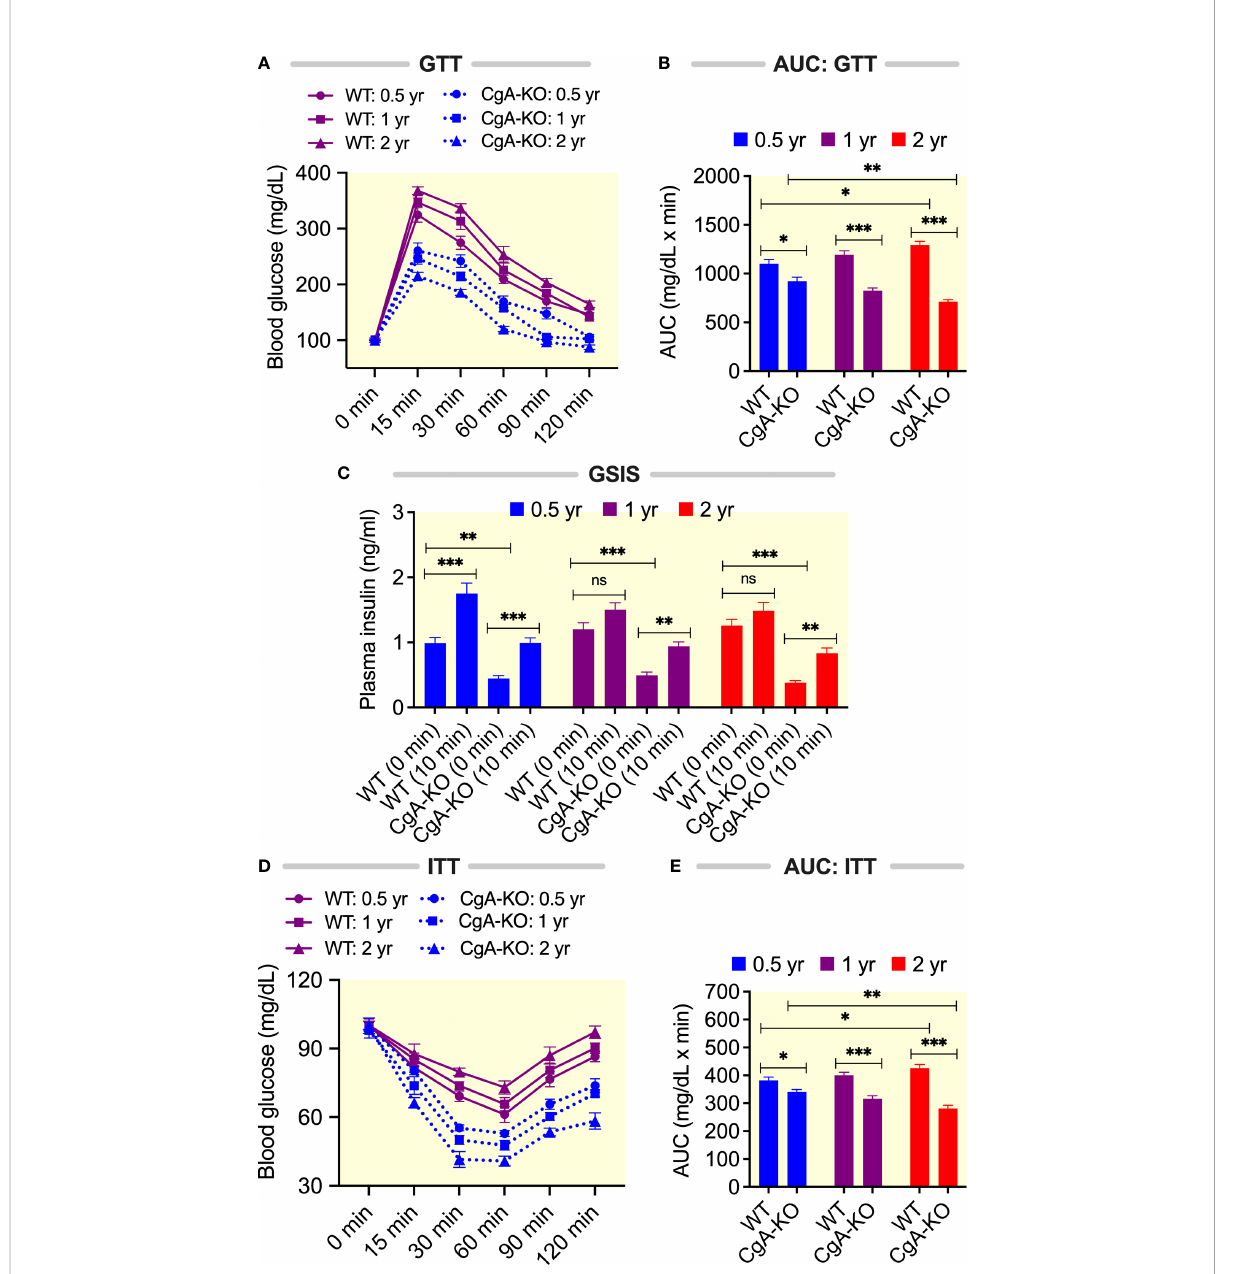
FIGURE 5 Aging CgA-KO mice maintain and improve glucose tolerance and insulin sensitivity. (A) Glucose tolerance test (GTT, n=7) with 8h fasting 0.5, 1 and 2 yr old WT and CgA-KO mice and (B) the corresponding areas under the curve (AUC). 2-way ANOVA. Interaction: p<0.001; Time: p<0.001; Genotype and age: p<0.001. (C) Glucose-stimulated insulin secretion (GSIS) with 8h fasting mice. Data were analyzed by 3-way ANOVA: Age: ns; Genotype; p<0.001; Treatment: p<0.001; Age: x Genotype: ns; Age x treatment: p<0.05; Genotype: x Treatment: ns; Age x Genotype